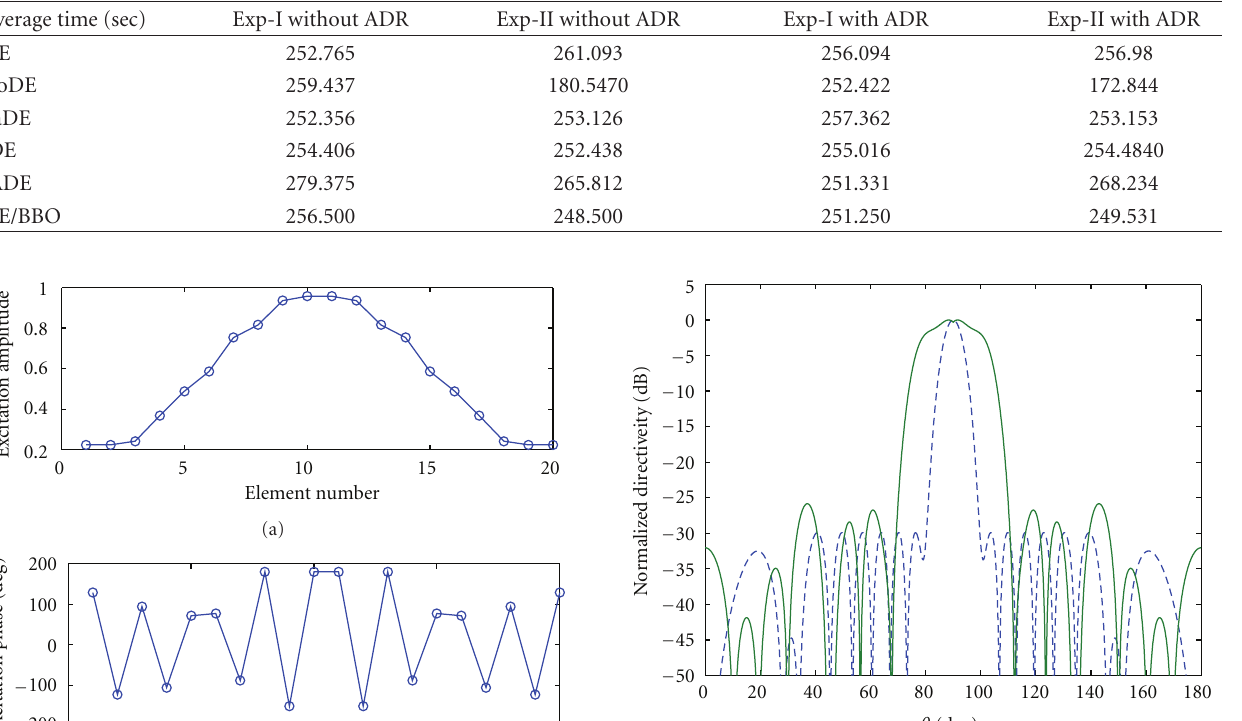
Table 8: The average computation running time (in seconds) achieved by di ff erent algorithm.